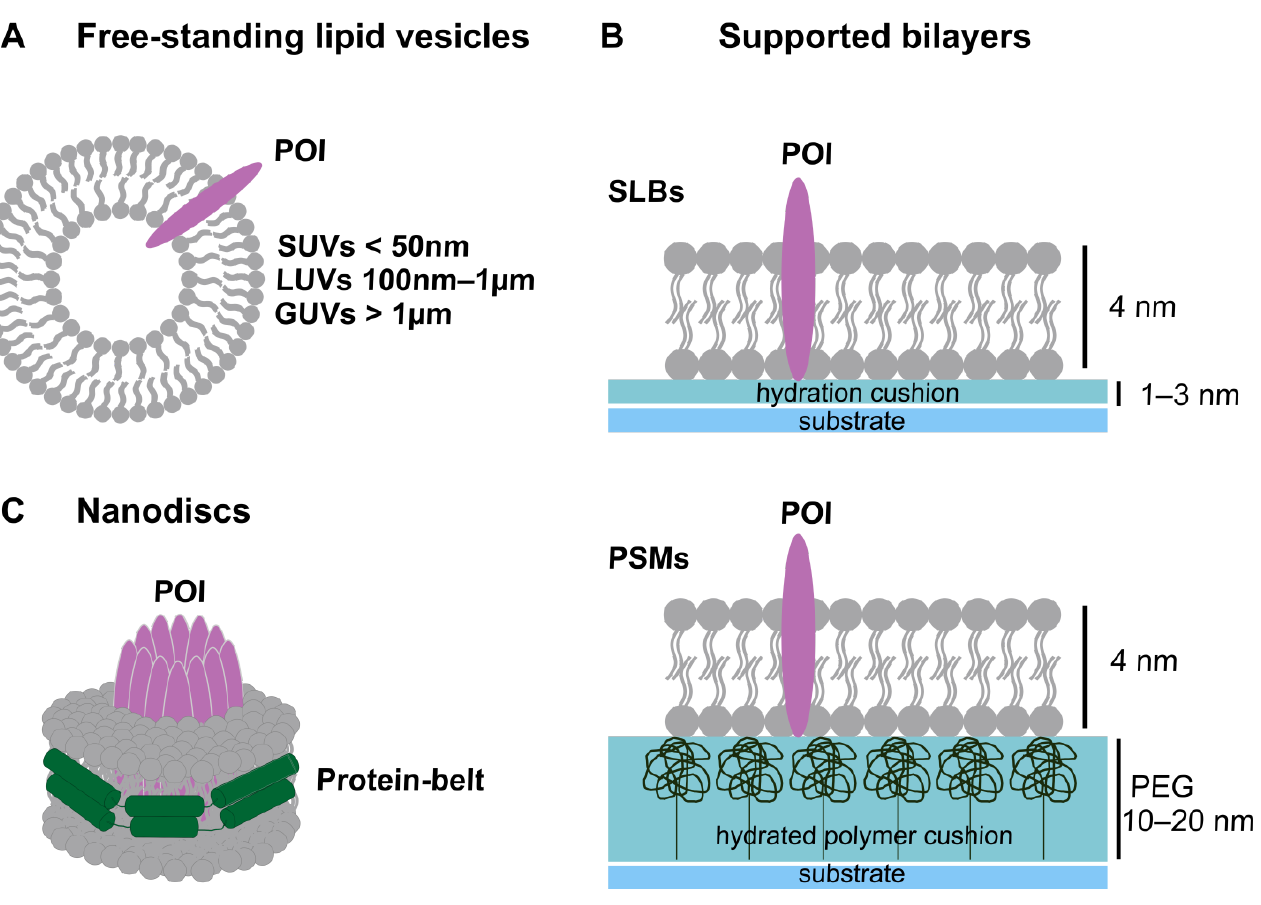
Figure 2. Artificial membrane systems. ( A ) Schematic representation of a free-standing lipid vesicle where a protein of interest (POI) is embedded in the membrane. ( B ) Schematic representation of ( top ) supported lipid bilayers (SLBs), and ( bottom ) polymer-supported membranes (PSMs) with embedded POI. ( C ) Schematic representation of a nanodisc with POIs incorporated in the lipid environment. Lipids are represented in gray and proteins in pink.